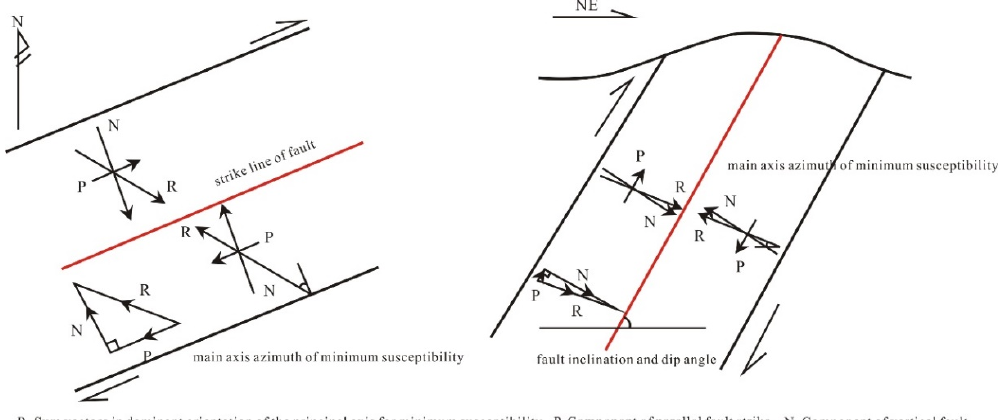
Figure 13. Analysis of the motion relationship between magnetic fabric and thrust fault.